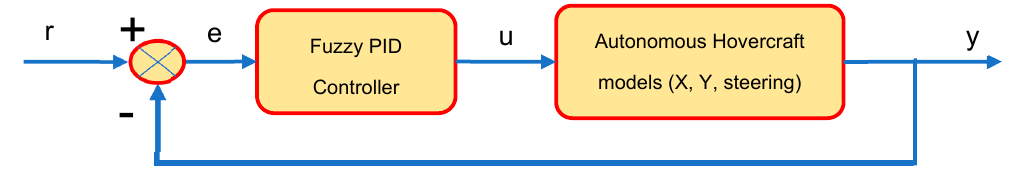
Figure 3. The controller block diagram.